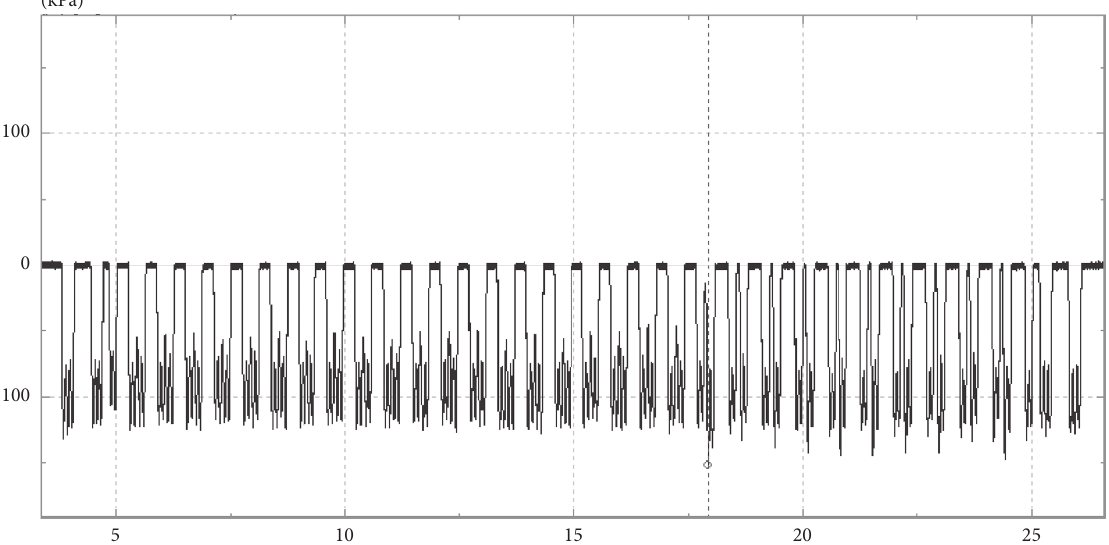
Figure 14: Vertical dynamic stress of the top surface of invert filling layer under the track in the repair